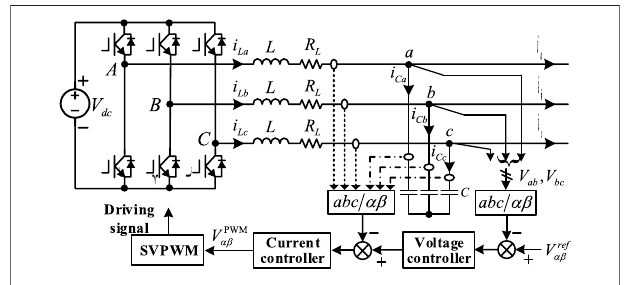
FIGURE 6 | Main circuit of the DVR and the related dual-loop control method.